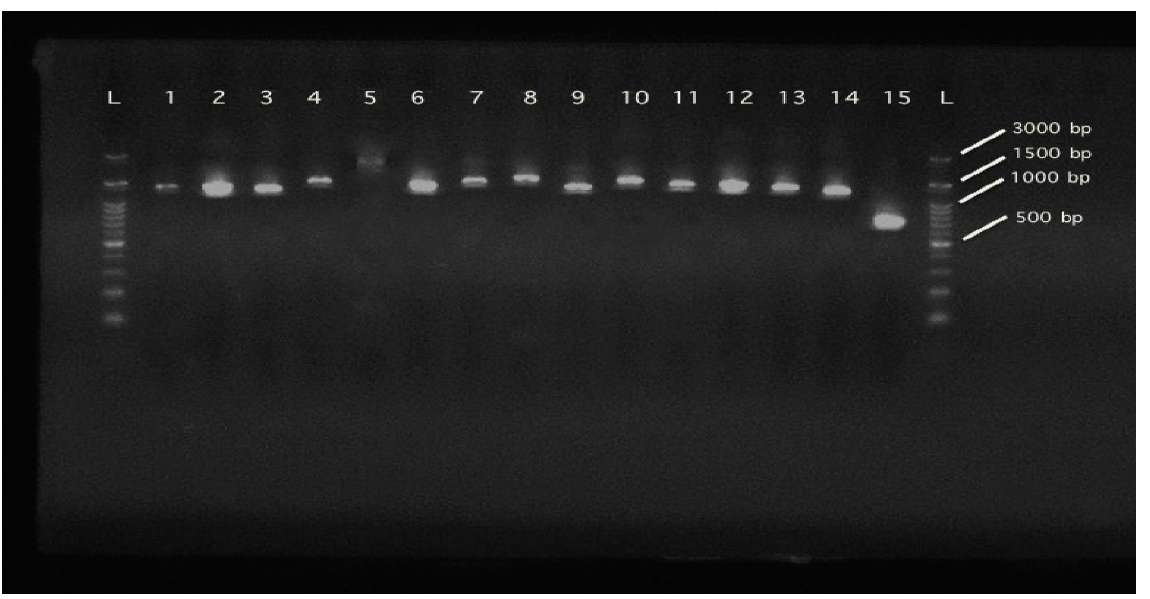
Figure 1. The fifteen PCR products from one individual amplified. Primer pair numbers according to Table 1. L: 100 bp Ladder (H3 RTU, GeneDireX). Table 1. L: 100 bp Ladder (H3 RTU,